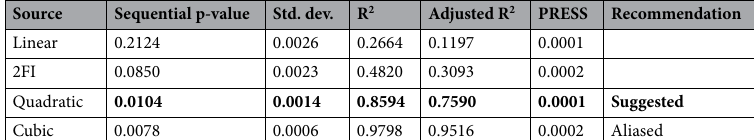
Table 11. Model summary statistics of exploitation zone for hot-rolled steel. Significant values are in bold.